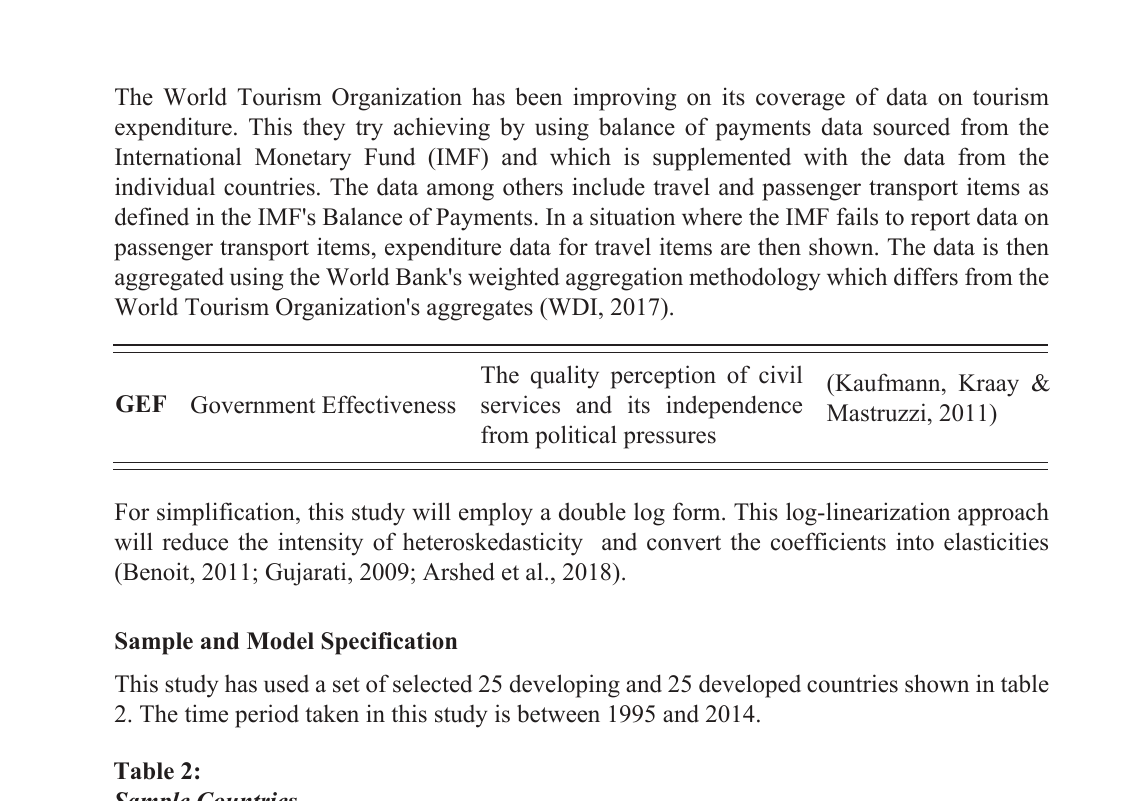
Sample Countries Developed